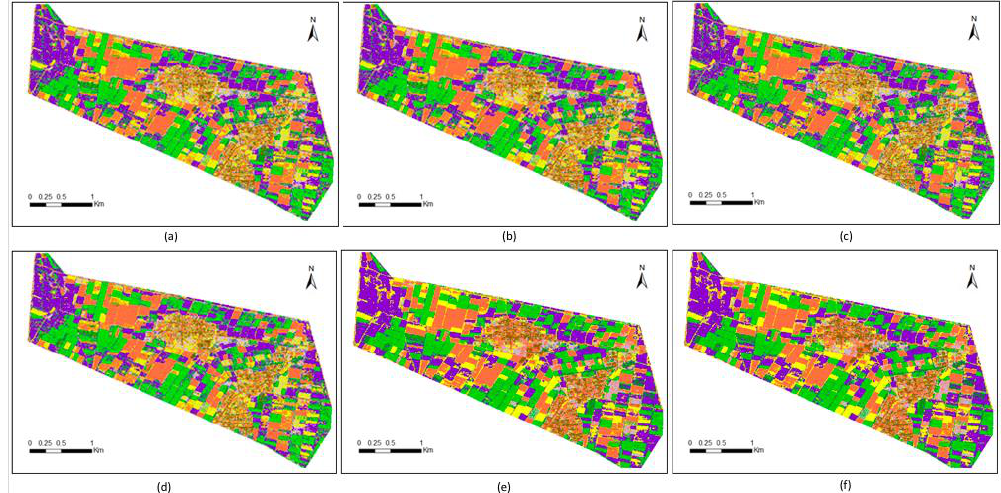
Figure 7. The classification maps of SS-ELM experiments, ( a ) experiment 1, ( b ) experiment 2, ( c ) experiment 3, ( d ) experiment 4, ( e ) experiment 5, ( f ) experiment 6.